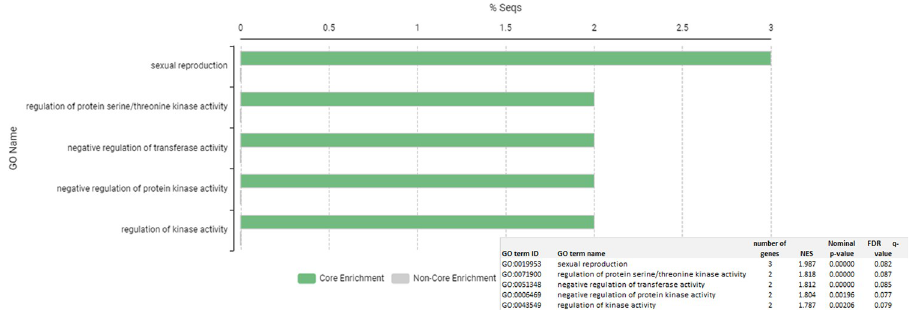
Fig 5. Gene Set Enrichment Analysis (GSEA) bar chart for the 98 differential abundant genes between climatic conditions. Top Go terms by the Normalized Enrichment Score (NES) for an FDR < 0.1. FDR = False discovery rate. % Seqs = percentage of sequences in each GO term.